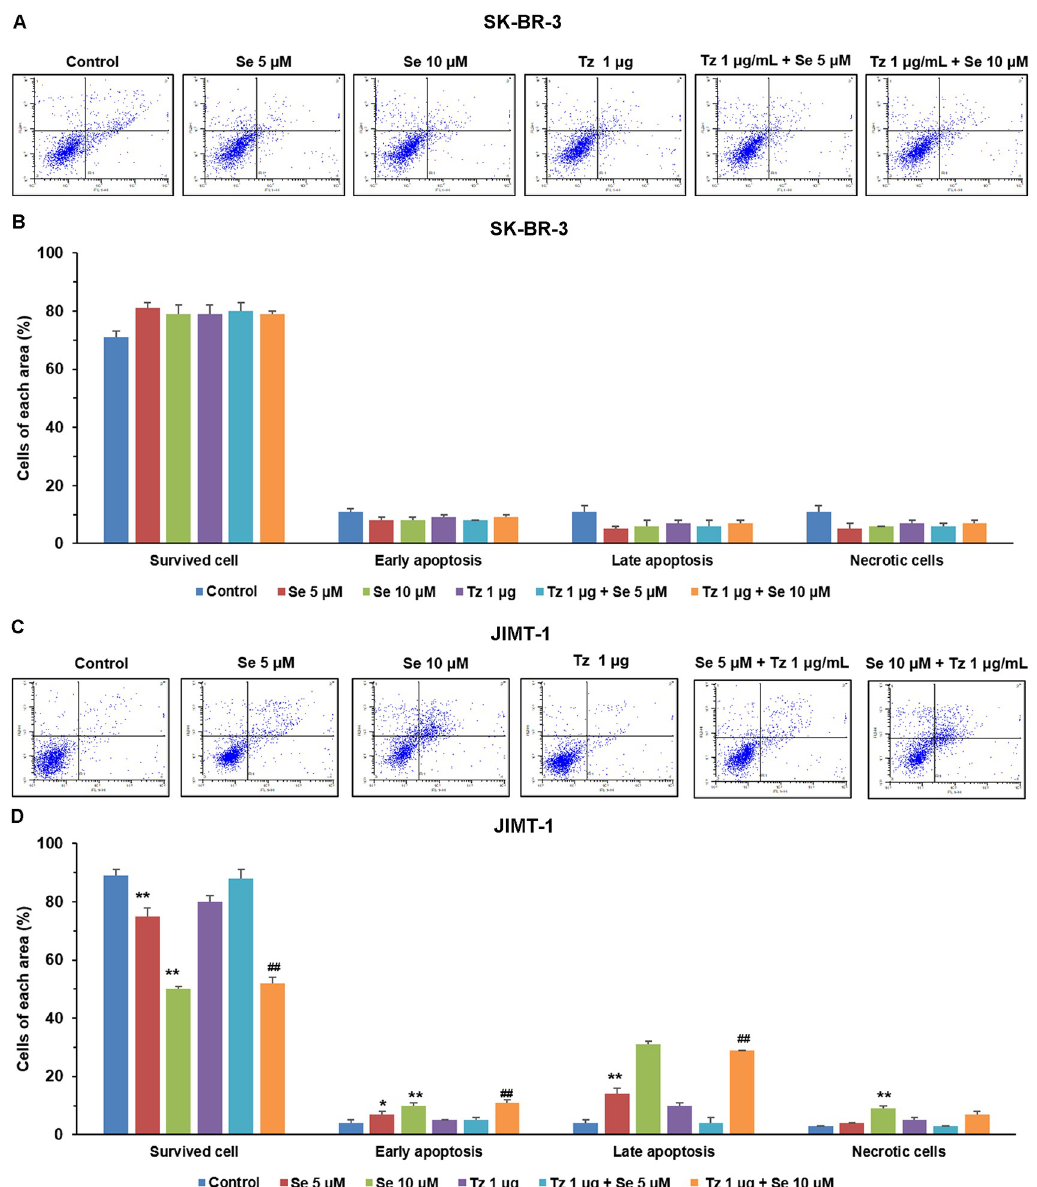
Fig 3. Effects on apoptosis in Tz-sensitive (A, B) and -resistant (C, D) breast cancer cell lines. Cells were treated with Se, Tz, or combinations of both drugs for 72 h. Cell deaths after treatments were analyzed by flow cytometry. Blue dots shows cell survival in the left lower quadrant, early apoptosis in right lower quadrant, late apoptosis in right upper quadrant and necrosis in left upper quadrant. Bars represent percentage of cells in each area analyzed by using flow cytometry. One-way ANOVA followed by post Scheffe test was used for statistical analysis to compare between groups. ( � P < 0.05; �� P < 0.01 significantly different from control; # P < 0.05; ## P < 0.01 significantly different from Tz single treatment).